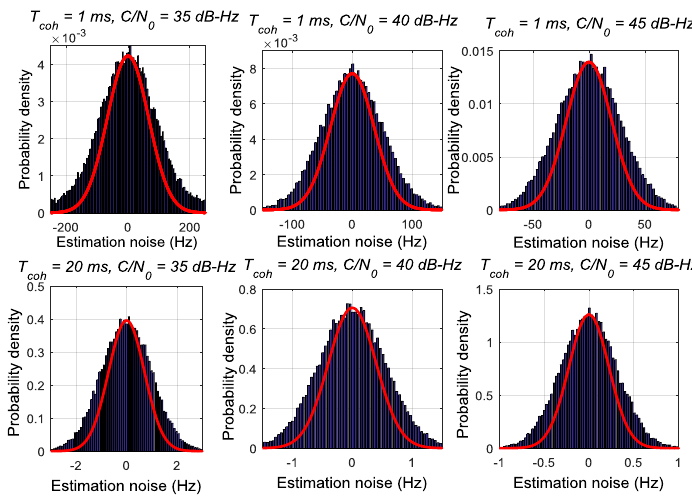
Figure 3. The estimation noise distribution of ATAN2 discriminator in different T coh and C / N 0 .